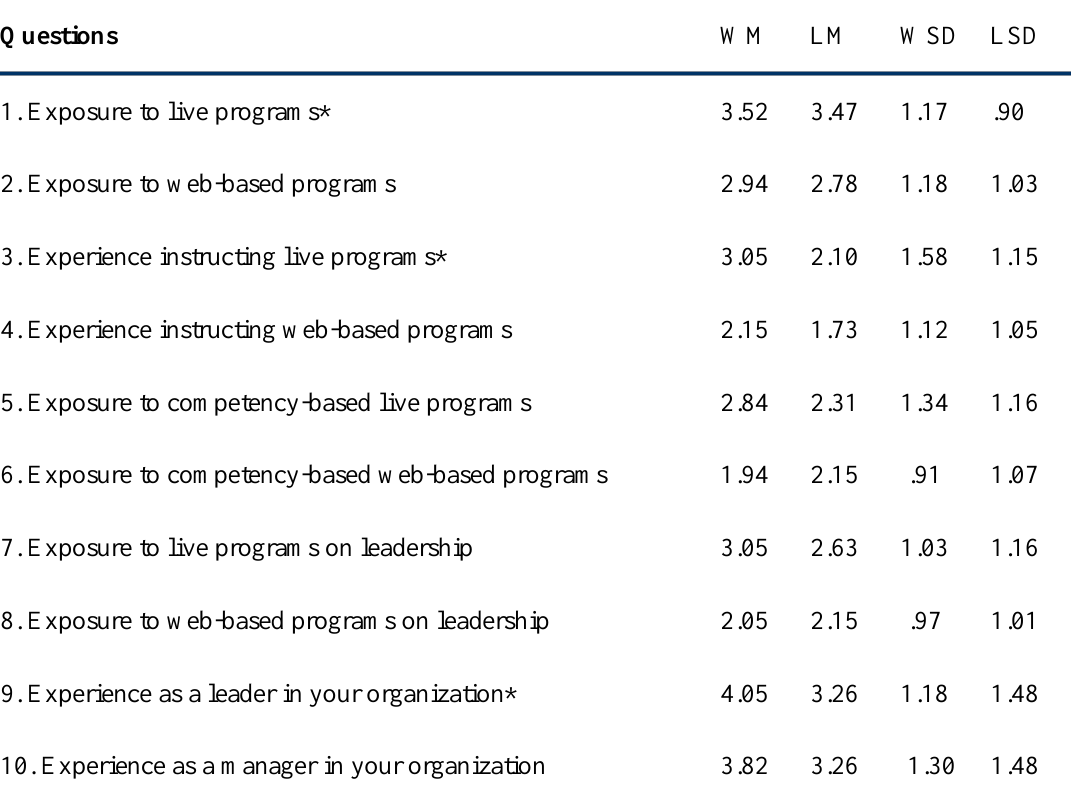
Professional Development